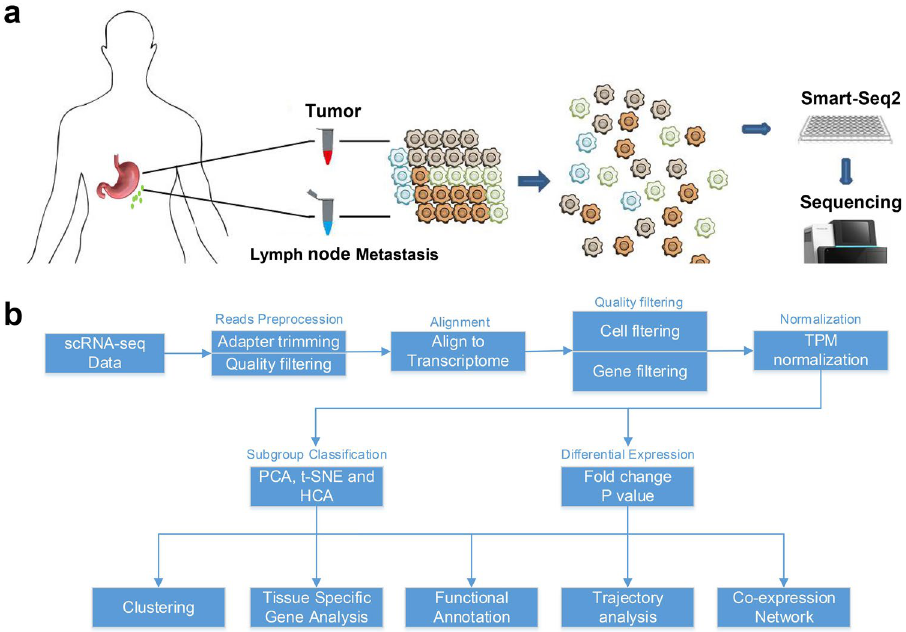
Figure 1. ( a ) Overview of the study design and sampling protocol. ( b ) Analysis pipeline in the current single- cell RNA-seq